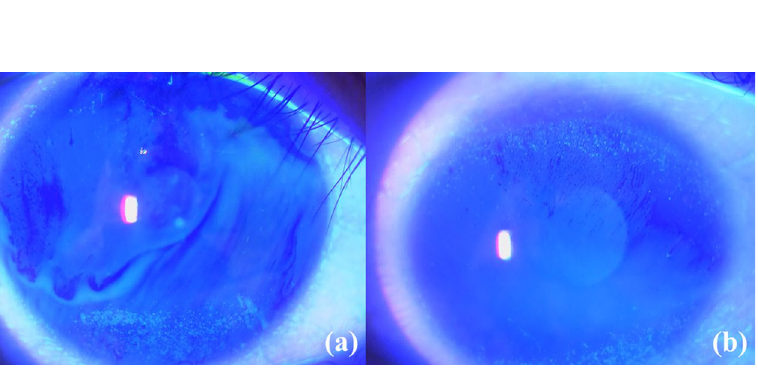
Figure 1. Tear film break-up patterns in thyroid eye disease. ( a ) Line break, ( b ) spot break, ( c) dimple break.